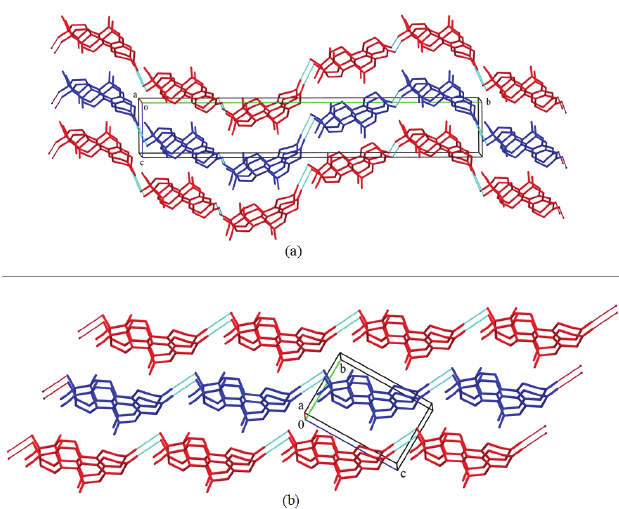
FIGURE 5 - Packing of forms I (a) and II (b) of tibolone projected onto their respective bc planes